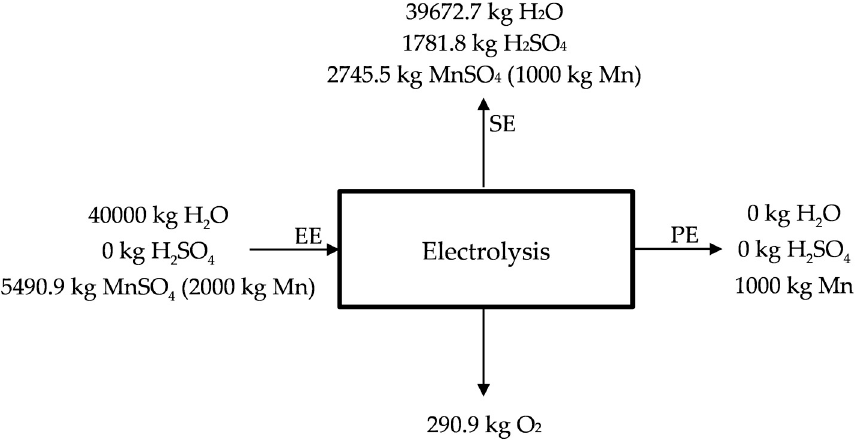
Figure 6. Manganese electrolytic process.